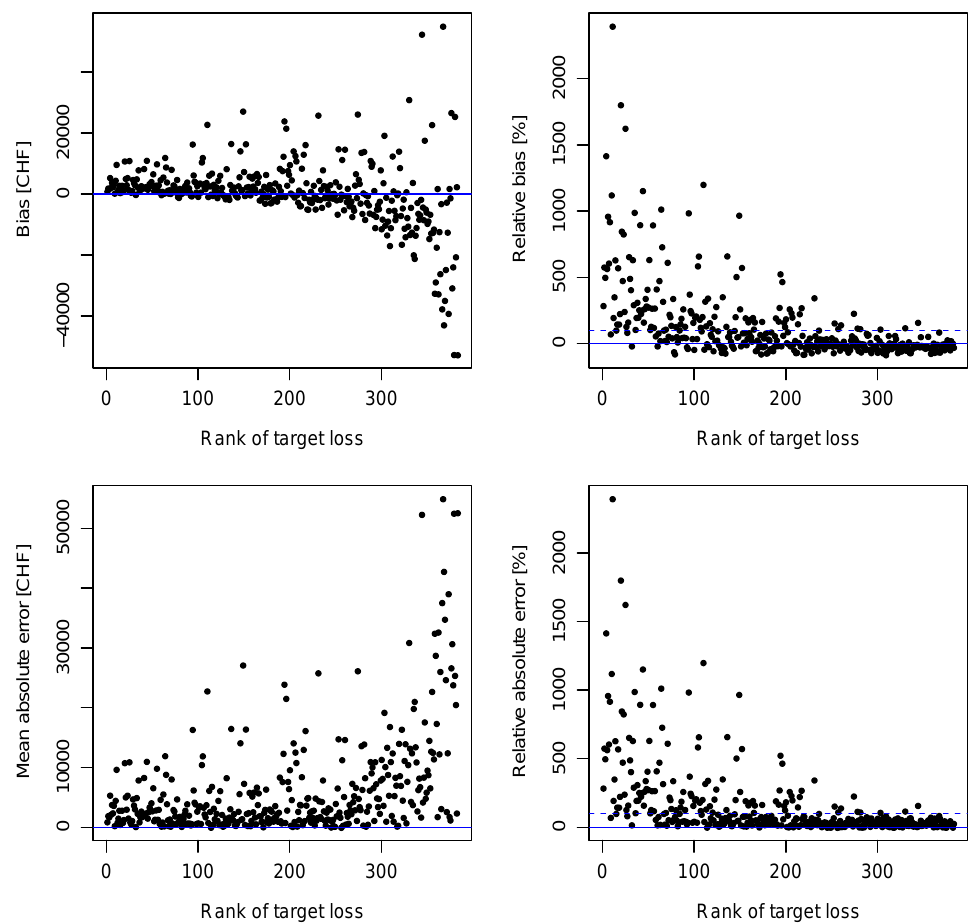
Figure A5. Dependence of single errors on ranking. Absolute errors show high variability in higher ranks of target loss (original scale), whereas relative errors are more variable in lower